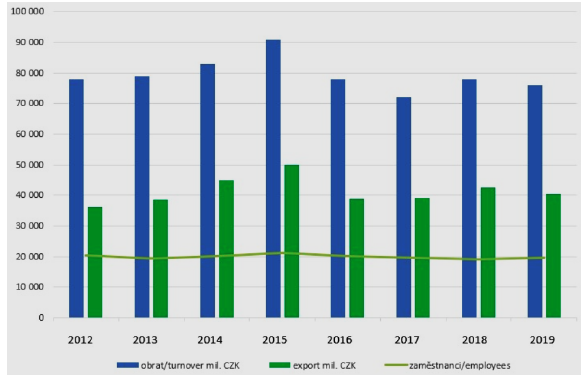
Figure 2. Exports of railway vehicles (includ- ing hovertrains) and associated equipment, source: ACRI [2].